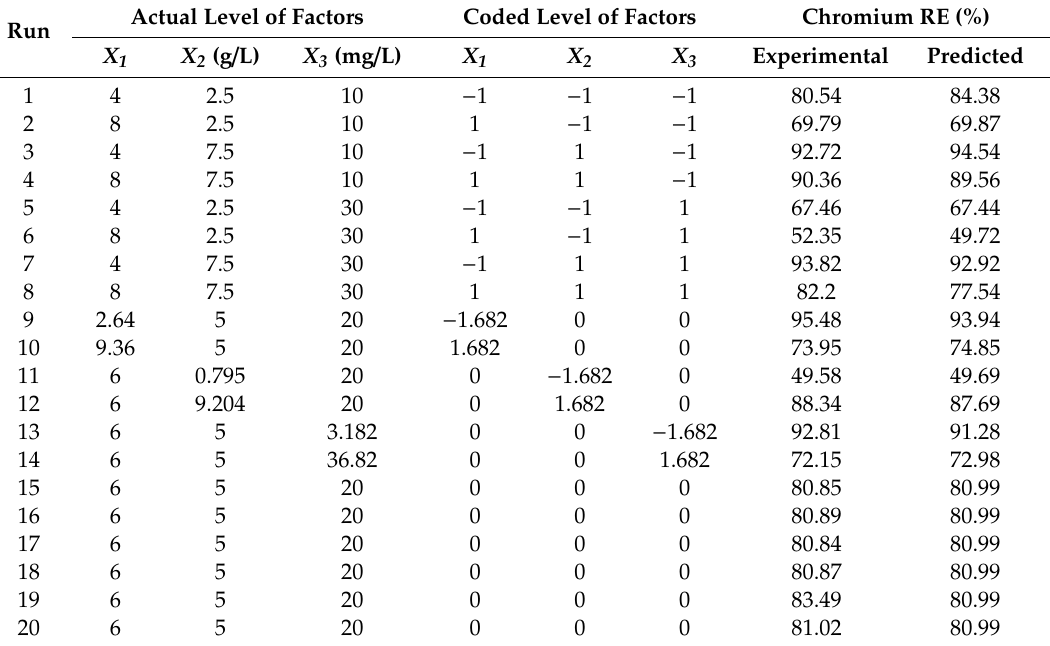
Table 2. Experimental design matrix and results for adsorption of